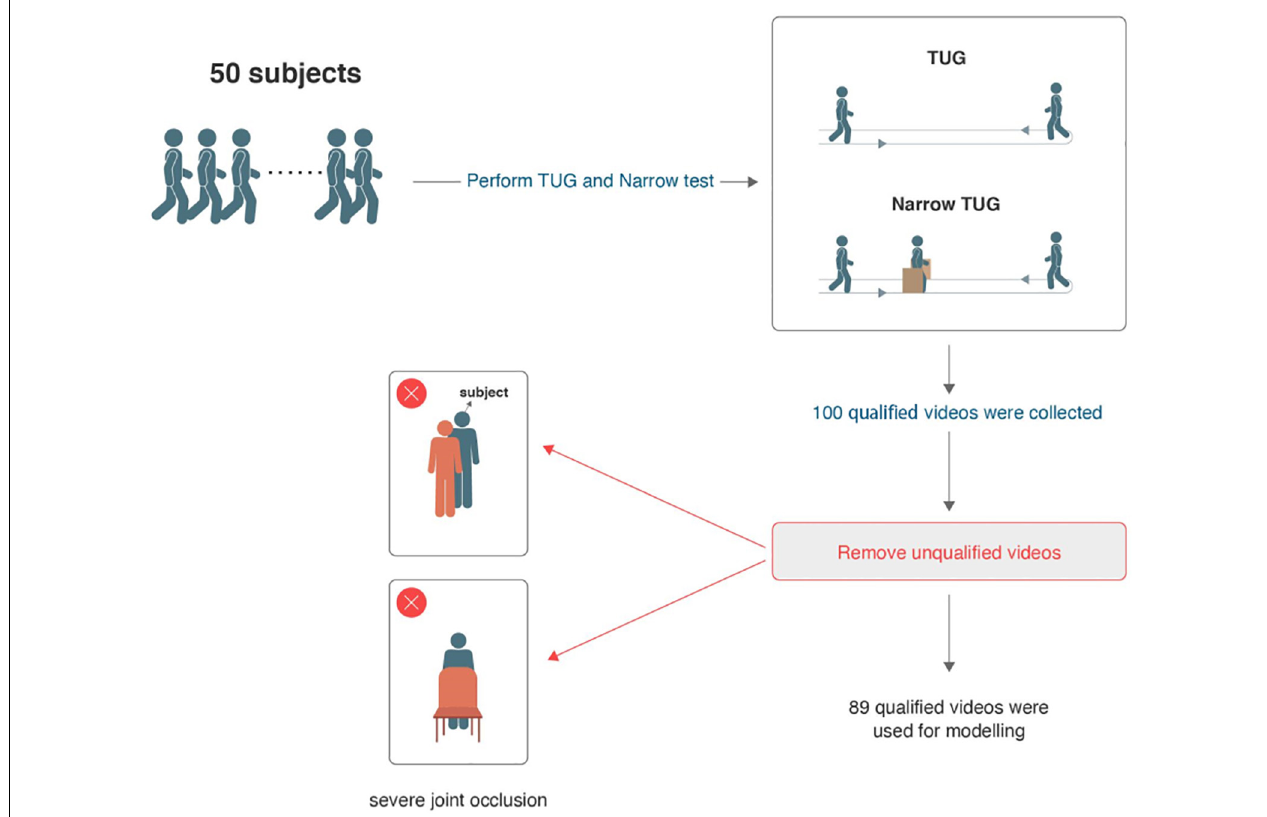
FIGURE 5 | Dataset collection